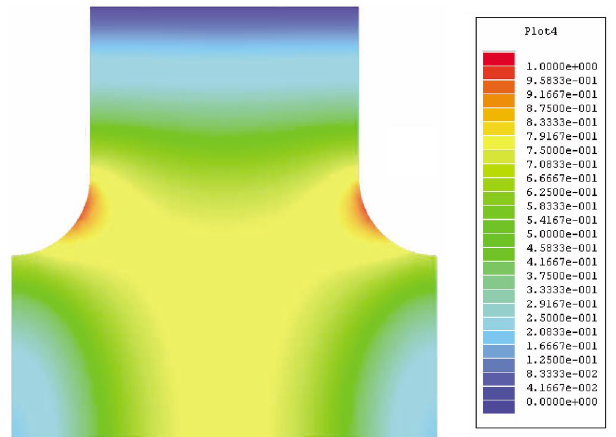
FIG. 2. (Color) Absolute value of the electric field in one cell of the H60VG3 structure.